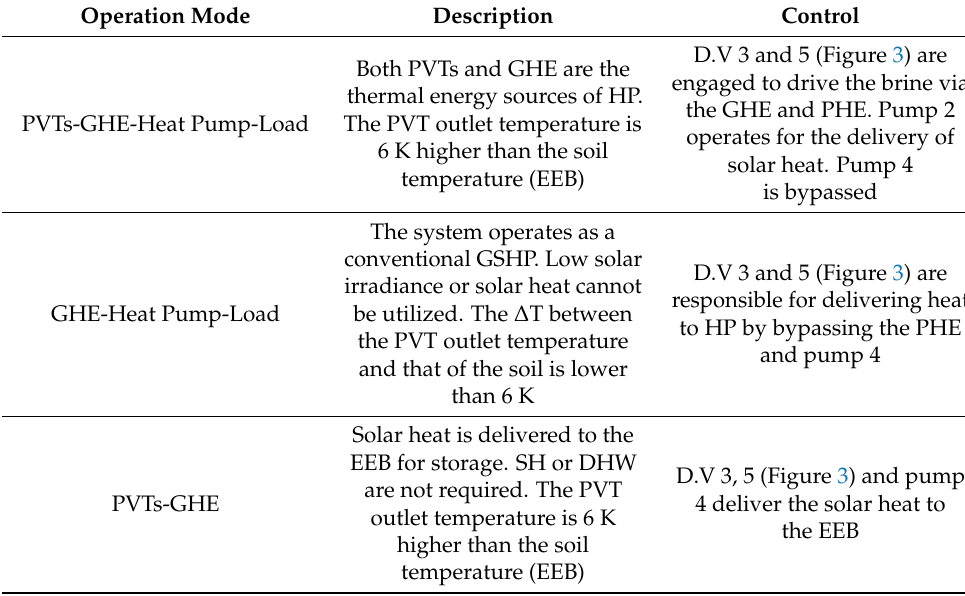
Table 1. The system’s main operation modes. Where: D.V is deviation valve; PHE is plate heat exchanger; and HP is heat